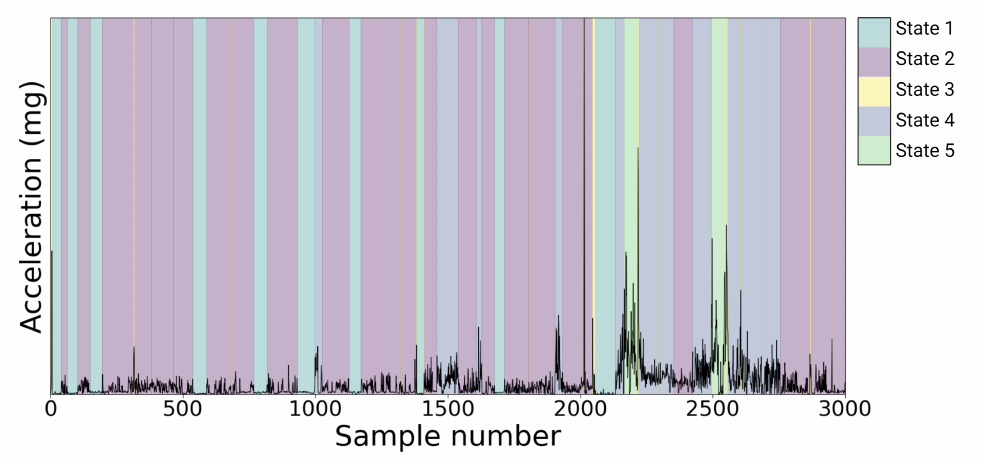
Figure 2. Example of activity segmentation with HSMM inference on the average